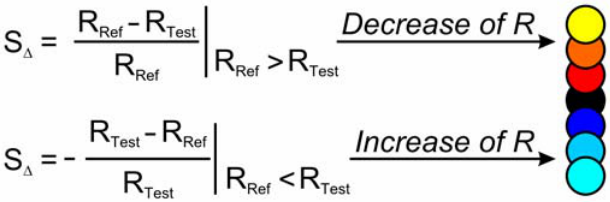
Figure 5. Calculation of the relative sensitivity and colour translation for the